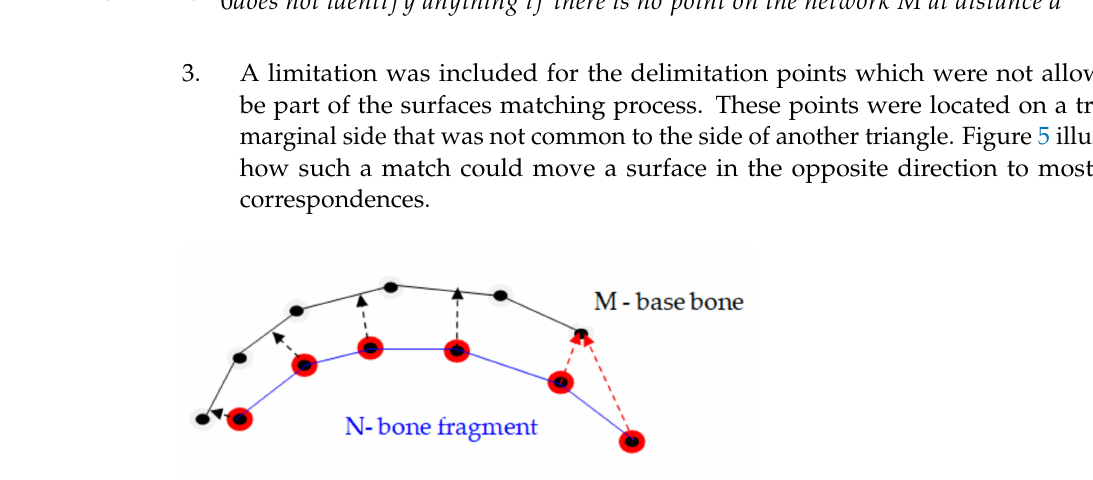
Figure 5. Matching the points between the N and M nodes of two surfaces (defined by the meshes of triangular networks). Vectors in red indicate matches that should be avoided, as they will cause the N surface to be erroneously shifted up and to the